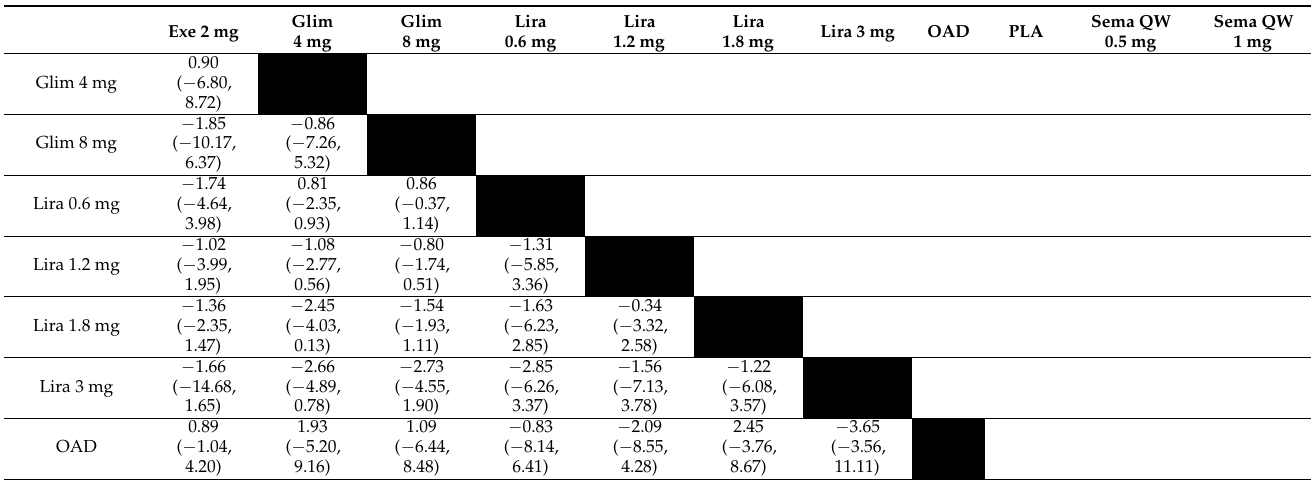
Table 4. NMA matrix for weight change from baseline: treatment